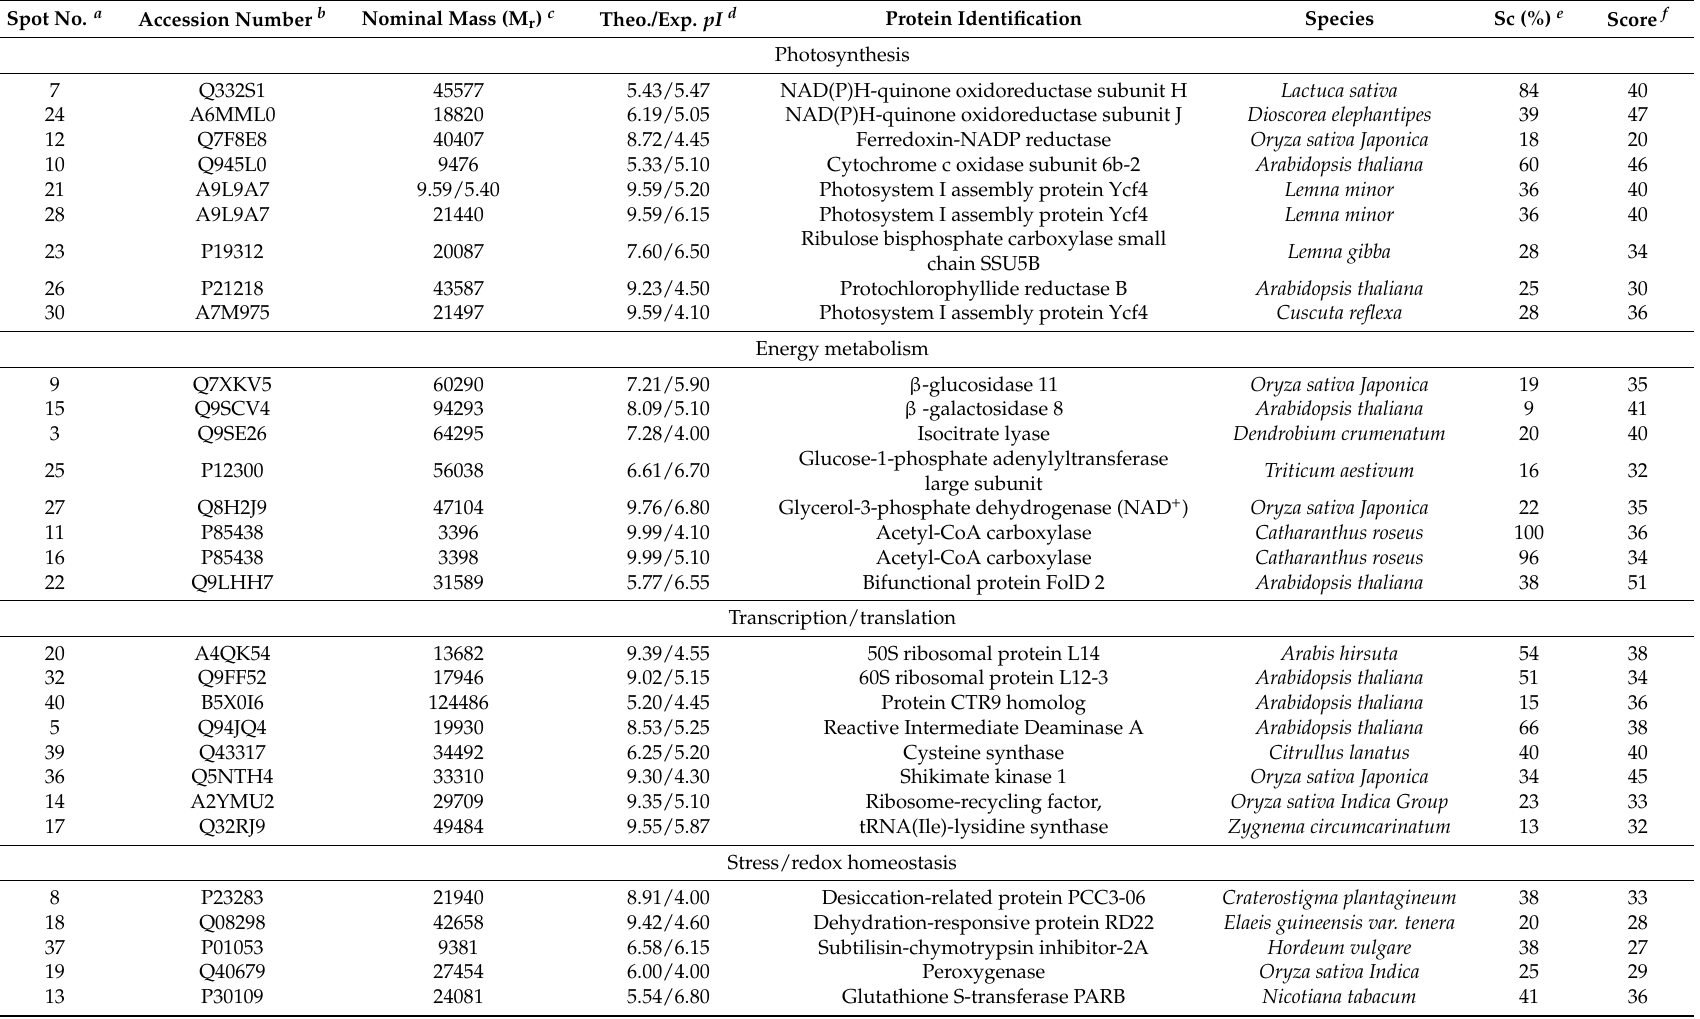
Table 1. Differentially-expressed protein spots identified from the two-dimensional gel electrophoresis of Rosa hybrida ‘Rock Fire’ leaf proteome. Spot No.